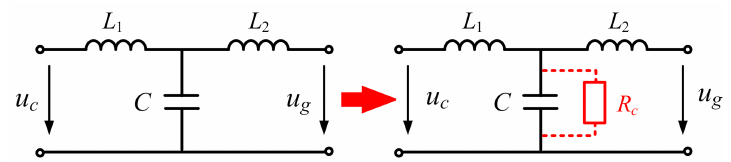
Figure 4. Equivalent circuit of LCL filter after adopting active damping.